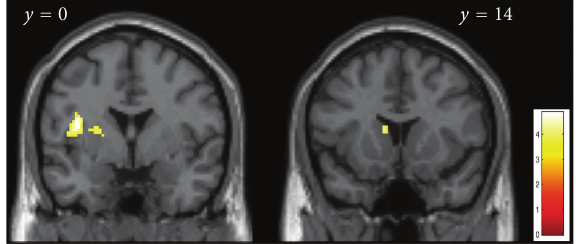
Figure 4: Visualization of brain regions related to liking. Coronal sections with statistical activation maps of the liking e ff ect, at y = 0 (left), and y = 14 (right). Areas showing increased activity with increased liking were (left section): left anterior insula, rolandic operculum, and putamen; (right section): caudate nucleus. Random e ff ects analysis; P < 0 . 001, uncorrected, only clusters of more than 10 voxels included. The left side of each section corresponds to the left hemisphere.